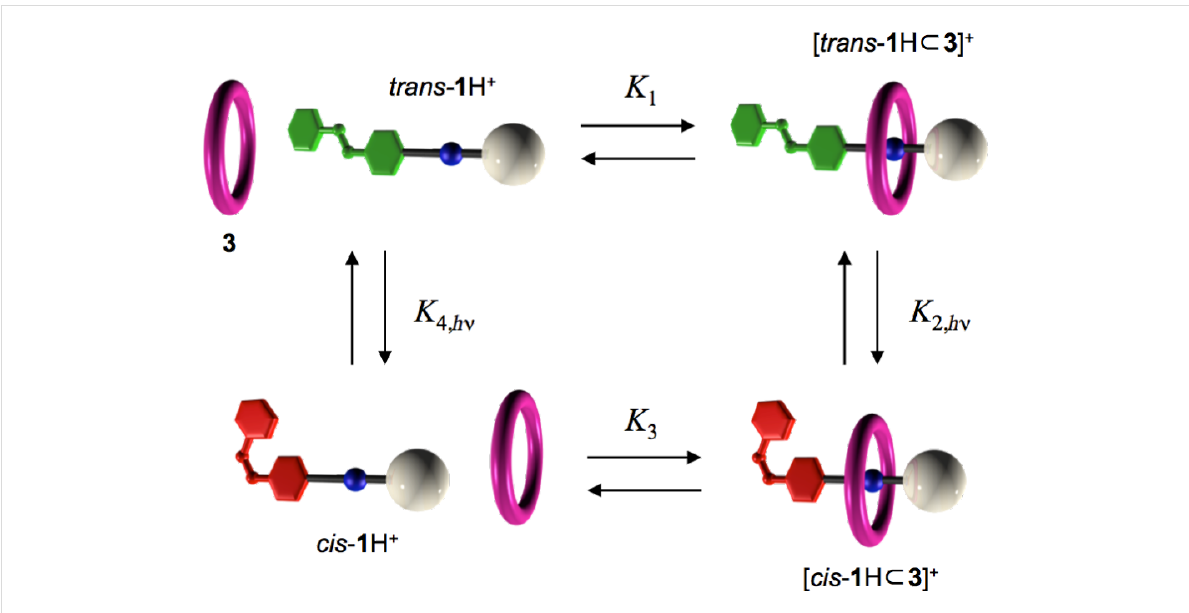
Figure 5: Self-assembly chemical reactions (horizontal processes) and photochemical isomerization reactions (vertical processes) that describe the operation of the molecular pump. The chemical or photochemical equilibrium constants refer to reactions read from left to right and from top to bottom. Figure adapted with permission from [18], copyright 2006 American Chemical